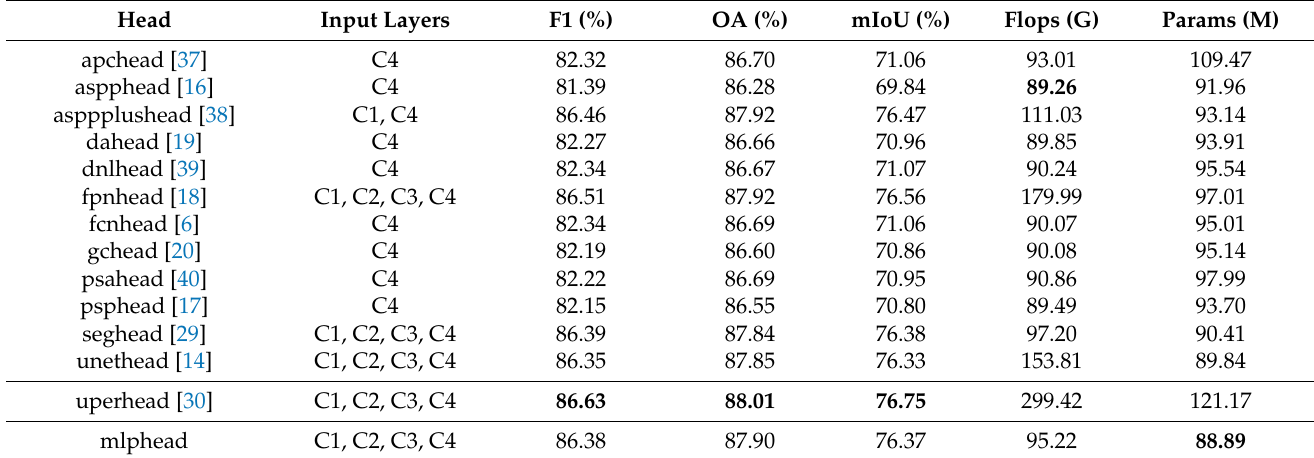
Table 5. The results of Swin-B with different segmentation head on the Vaihingen dataset.